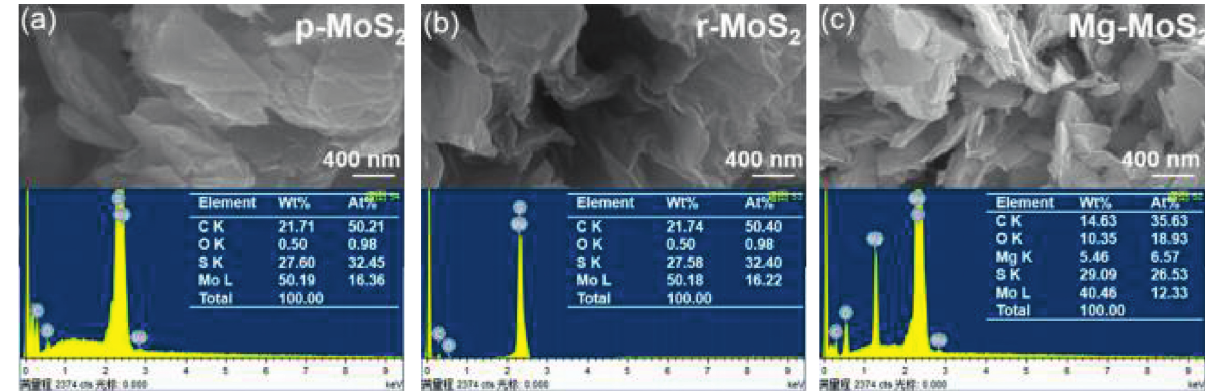
2 nanosheets [127].